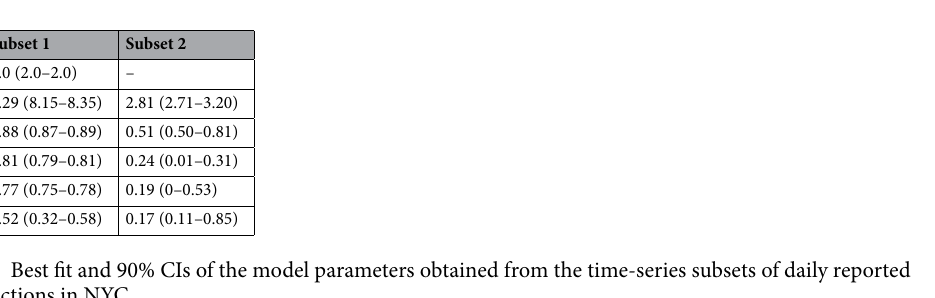
Table 1. Best fit and 90% CIs of the model parameters obtained from the time-series subsets of daily reported new infections in NYC.